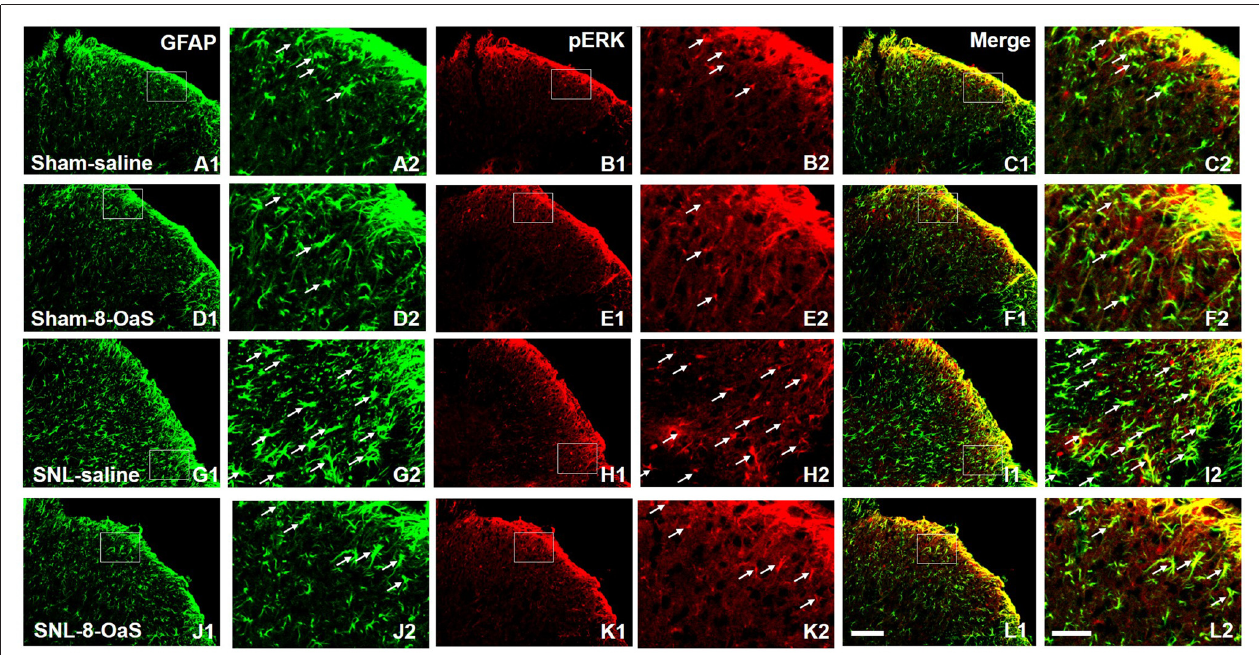
FIGURE 6 | 8-OaS inhibited SNL-induced spinal astrocytic ERK activation. SNL induced a marked increase in astrocytic activation and ERK activation in the ipsilateral spinal dorsal horn on POD 15, as indicated by the up-regulation of GFAP staining (A,G) and pERK staining (B,H) respectively. The GFAP/pERK double-labeled neurons (C,I) were also increased after SNL. 8-OaS decreased the density of GFAP (G,J) and pERK (H,K) staining as well as the number of GFAP and pERK double-labeled neurons (I,L) in the ipsilateral spinal dorsal horn after SNL. The framed area in images (A–L) was magnified in images (A (cid:48) –L (cid:48) ) , respectively. White arrows showed double-labeled neurons in each set of pictures. Bars = 100 µ m in images (A1–L1) and 40 µ m in images (A2–L2)